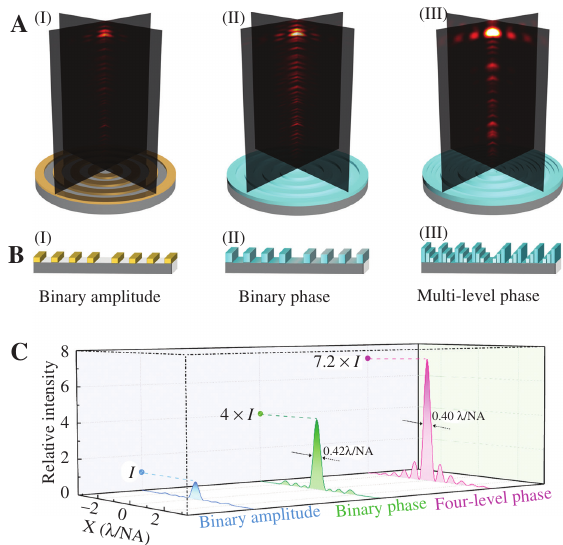
Figure 1: Schematic of the sub-diffraction-limit focusing with high efficiency from multilevel phase supercritical